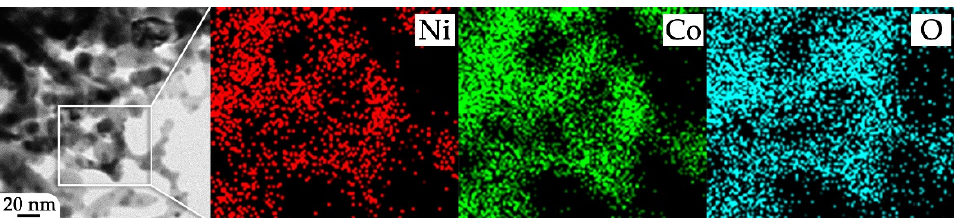
Figure 6. Maps of the element distribution on the surface of the oxide particles (according to TEM and EDX data).